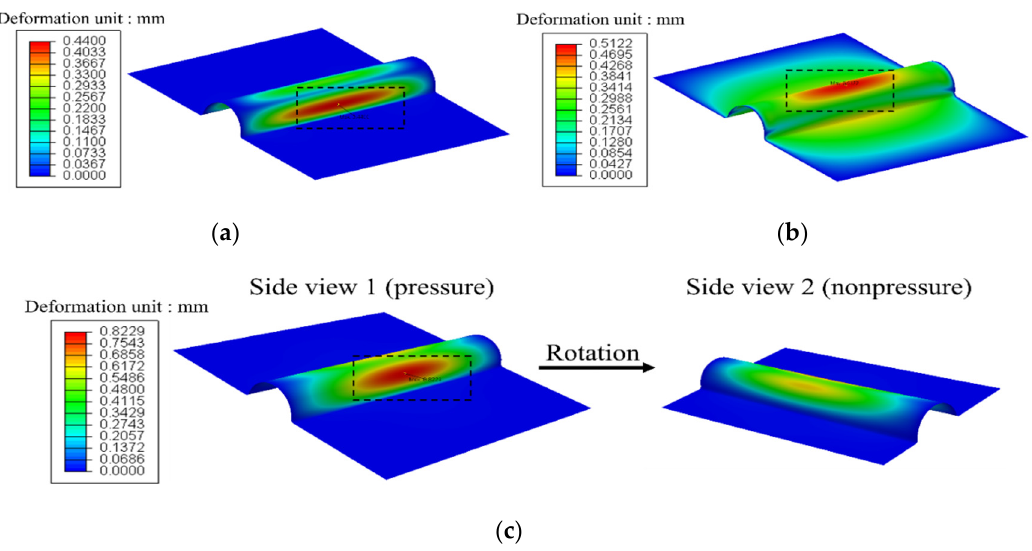
Figure 9. Deformed shapes for case No. 32 in ( a ) symmetric pressure analysis, ( b ) thermal shrinkage analysis, and ( c ) asymmetric pressure analysis. The black dashed rectangle represents the area of maximum deformation; side view 1 (pressure) shows the face exposed to pressure, and side view 2 (nonpressure) represents the opposite